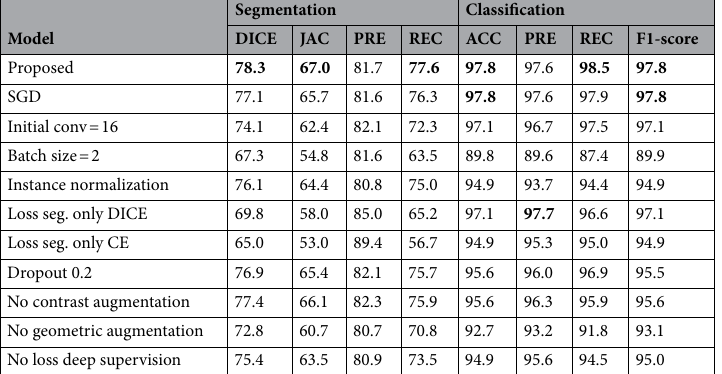
Table 2. Segmentation and classification performance of the ablation studies (mean). SGD Stochastic gradient descendent optimizer with Nesterov momentum (μ = 0.95). Loss Seg. only DICE – without cross entropy loss on Eq. (3) Loss Seg. only CE – without dice loss on Eq. (3) For each ablation experiment, one component of the proposed method was replaced or disable. For each row, the model column describes the component that was changed. Bold values indicate best